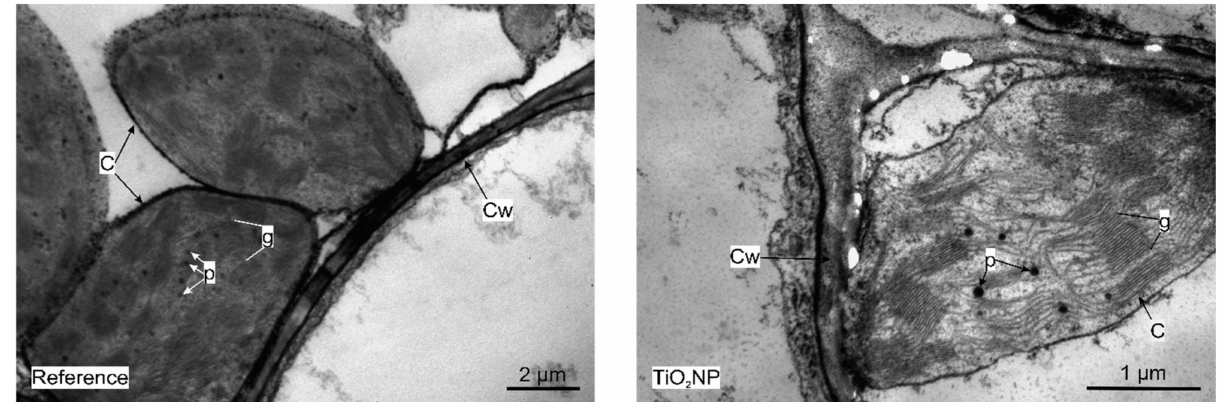
Figure 7. TEM micrographs of the untreated and TiO 2 NP treated leaves. C = chloroplast, Cw = cell wall, g = grana, p = plastoglobuli.